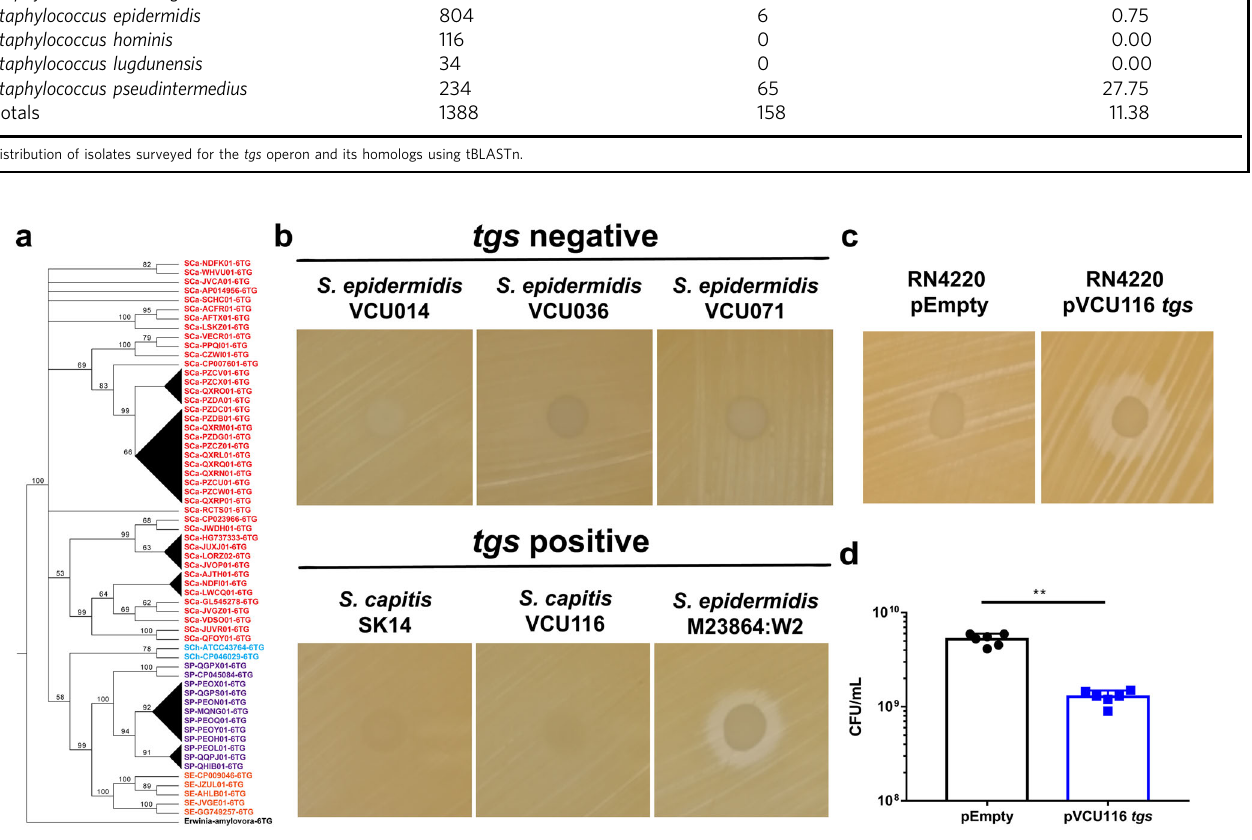
Fig. 3 The tgs operon is present in other staphylococcal species and functional. a Phylogenetic analysis of the 6-TG operon using completed and draft Staphylococcus genomes. Black triangles represent a clade that was collapsed because their internal bootstrap values were <50%. SCa S. capitis , SCh S. chromogenes , SE S. epidermidis , SP S. pseudintermedius . b Simultaneous antagonism assay of tgs -negative and -positive staphylococcal strains on TSA. c Simultaneous antagonism assay using RN4220 pEmpty and pVCU116 tgs on TSA. d S. aureus was cultured in TSB containing supernatant from RN4220 pEmpty or pVCU116 tgs and plated 24 h.p.i and CFU/mL were enumerated. Results are pooled from two independent experiments, each with n = 3 replicates per condition. Data are shown as mean ± SD (** p ≤ 0.01. Two-sided unpaired t